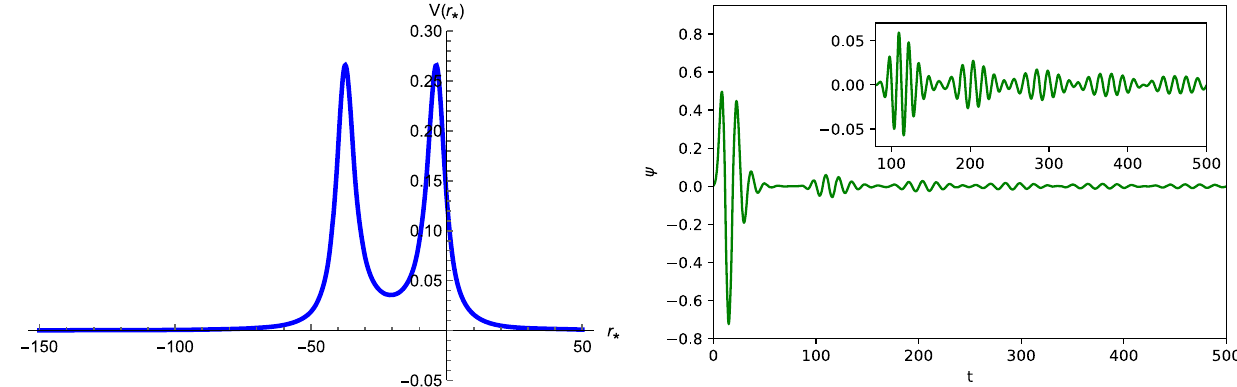
Fig. 7 The effective potential and gravitational wave echoes of the scalar field perturbation to black bounces in a cloud of strings with M = 0 . 5 , l = 1 , L = 0 . 1 , a = 1 . 13